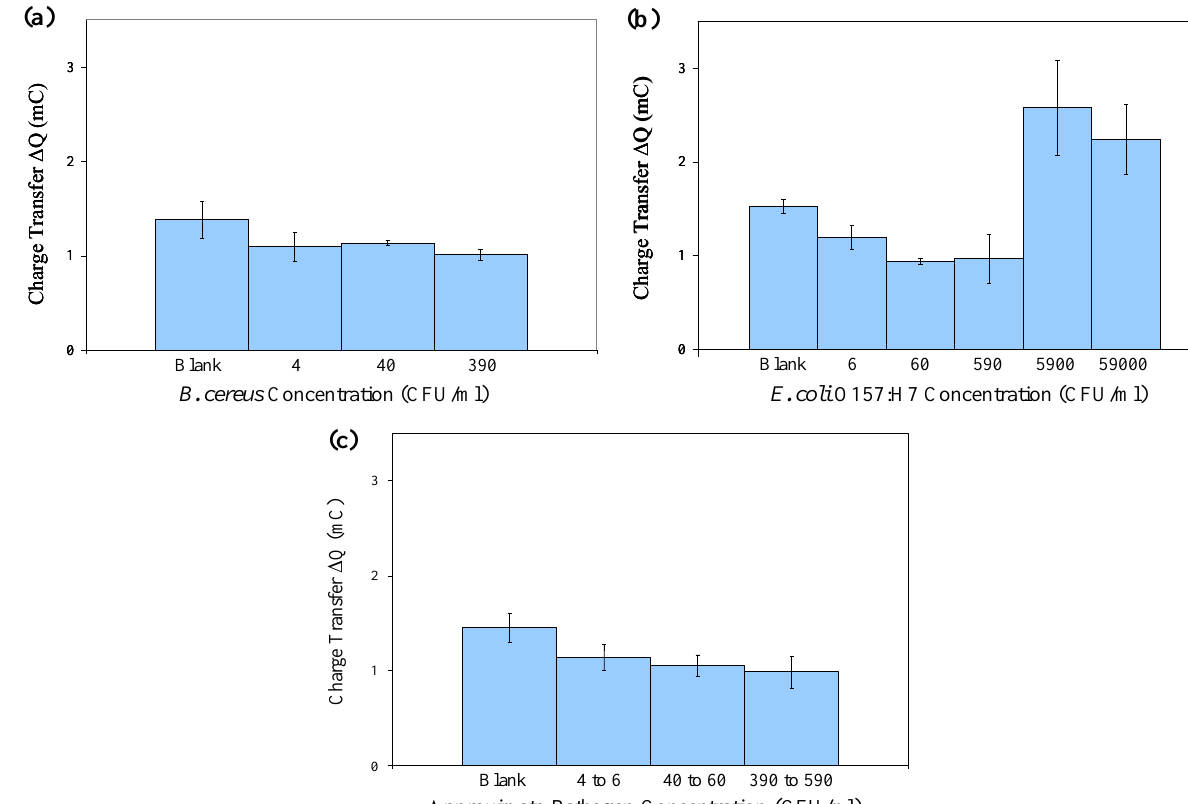
Figure 6. Mean charge transfer values obtained in cyclic voltammetry of immuno-c/sNP-cell solutions: ( a ) B. cereus cell concentrations ranging from 4 to 3.9 × 10 2 CFU/mL ( n = 3); ( b ) E. coli O157:H7 cell concentrations ranging from 6 CFU/mL to 5.9 × 10 4 CFU/mL ( n = 3); and ( c ) B. cereus and E. coli results displayed together ( n = 6). Error bars represent ± one standard